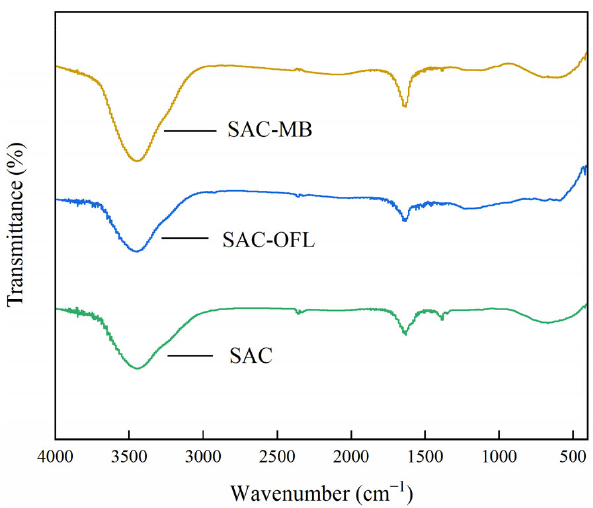
Figure 3. FTIR plots of the initial state of SAC and adsorption-saturated MB and OFL.